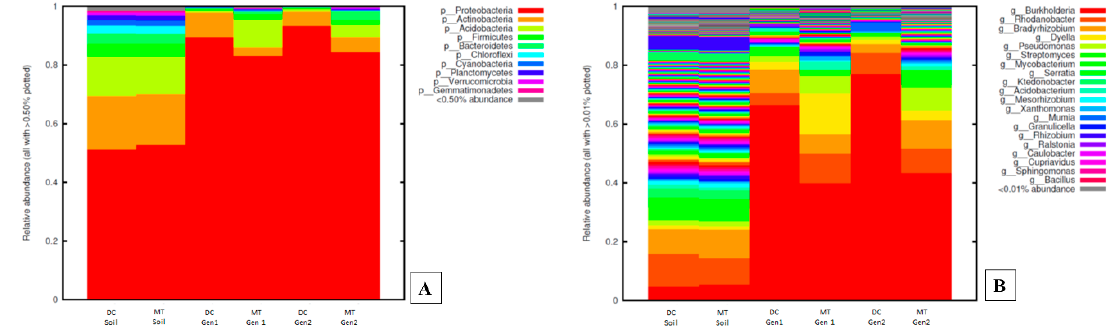
Figure 1. Bacterial diversity plotted as relative abundances shown at the phyla ( A ) and genus ( B ) levels, identified from the soils and the DC/MT chambers, respectively.